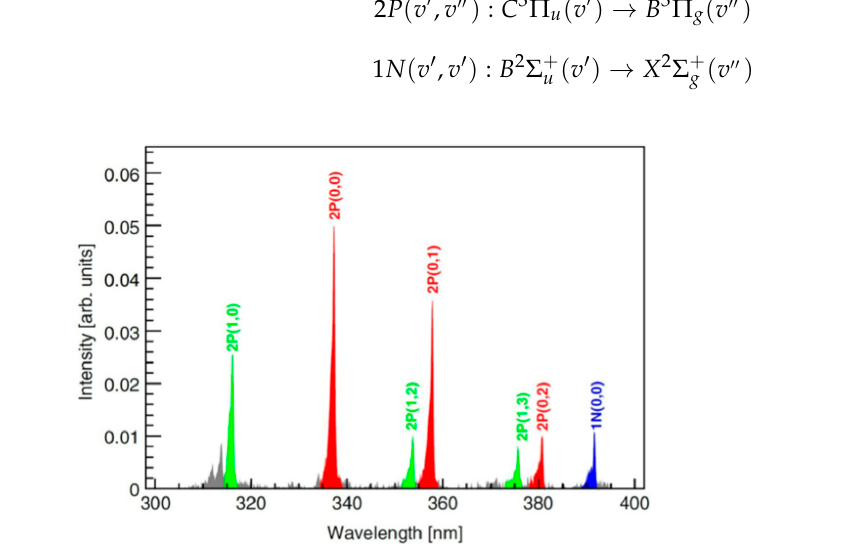
Figure 2. Air fluorescence spectrum in the 300–400 nm range. Peaks of different energies represent radioluminescence photons produced by different leapfrogging modes [48]. This figure is reprinted with the permission of Elsevier.